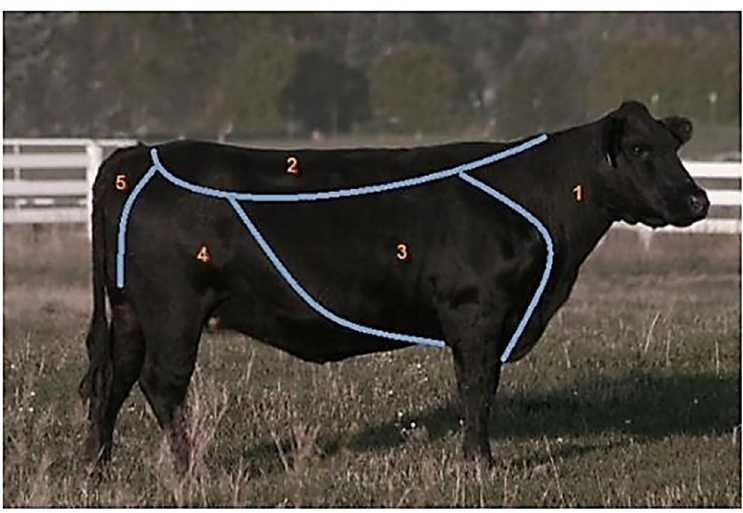
Fig 4. Anatomical zones (Z) differentiated for tick counting. Z1: head, ears, neck and dewlap to the point of the sternum; Z2: back and loin; Z3: forelegs, shoulders and ribs; Z4: rear legs, udder/scrotum, fore and rear flank; Z5: rump and tail. Image adapted from